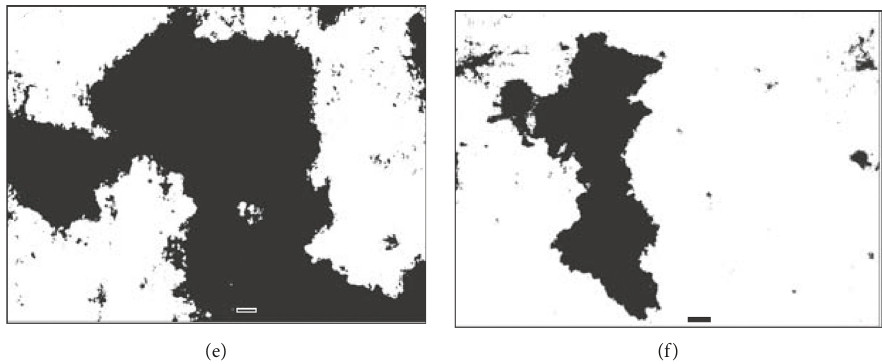
Figure 6: MTT images at 4 h (a–c) and 8h (d–f): SS polished (a, d), SS coated (b, e), and SS patterned (c, f). Black spots are bacterial accumulation on each surface. The bar is 20 µ